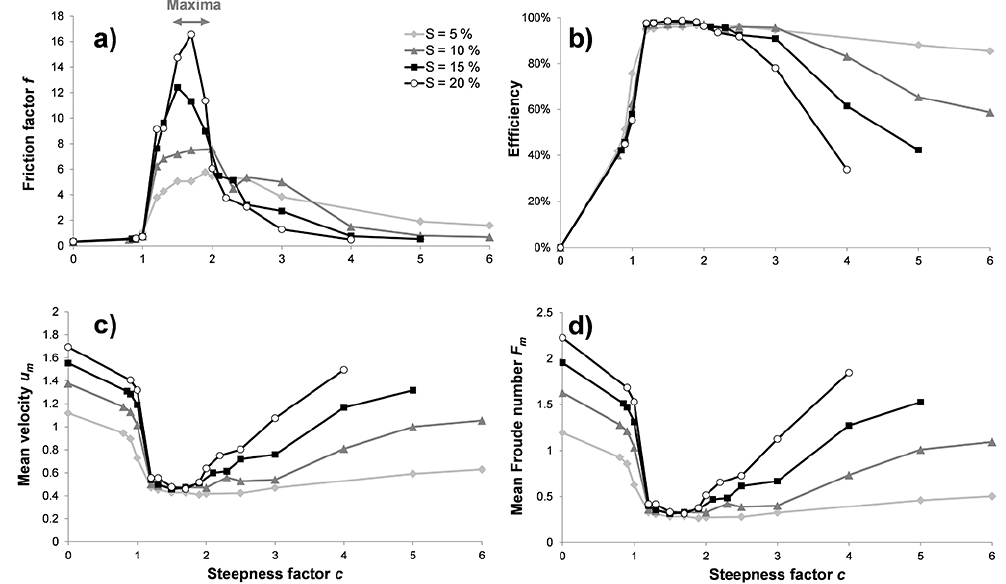
Fig. 9. Relationships between the steepness factor c and the friction factor f , efficiency, mean velocity u m and mean Froude number F m for